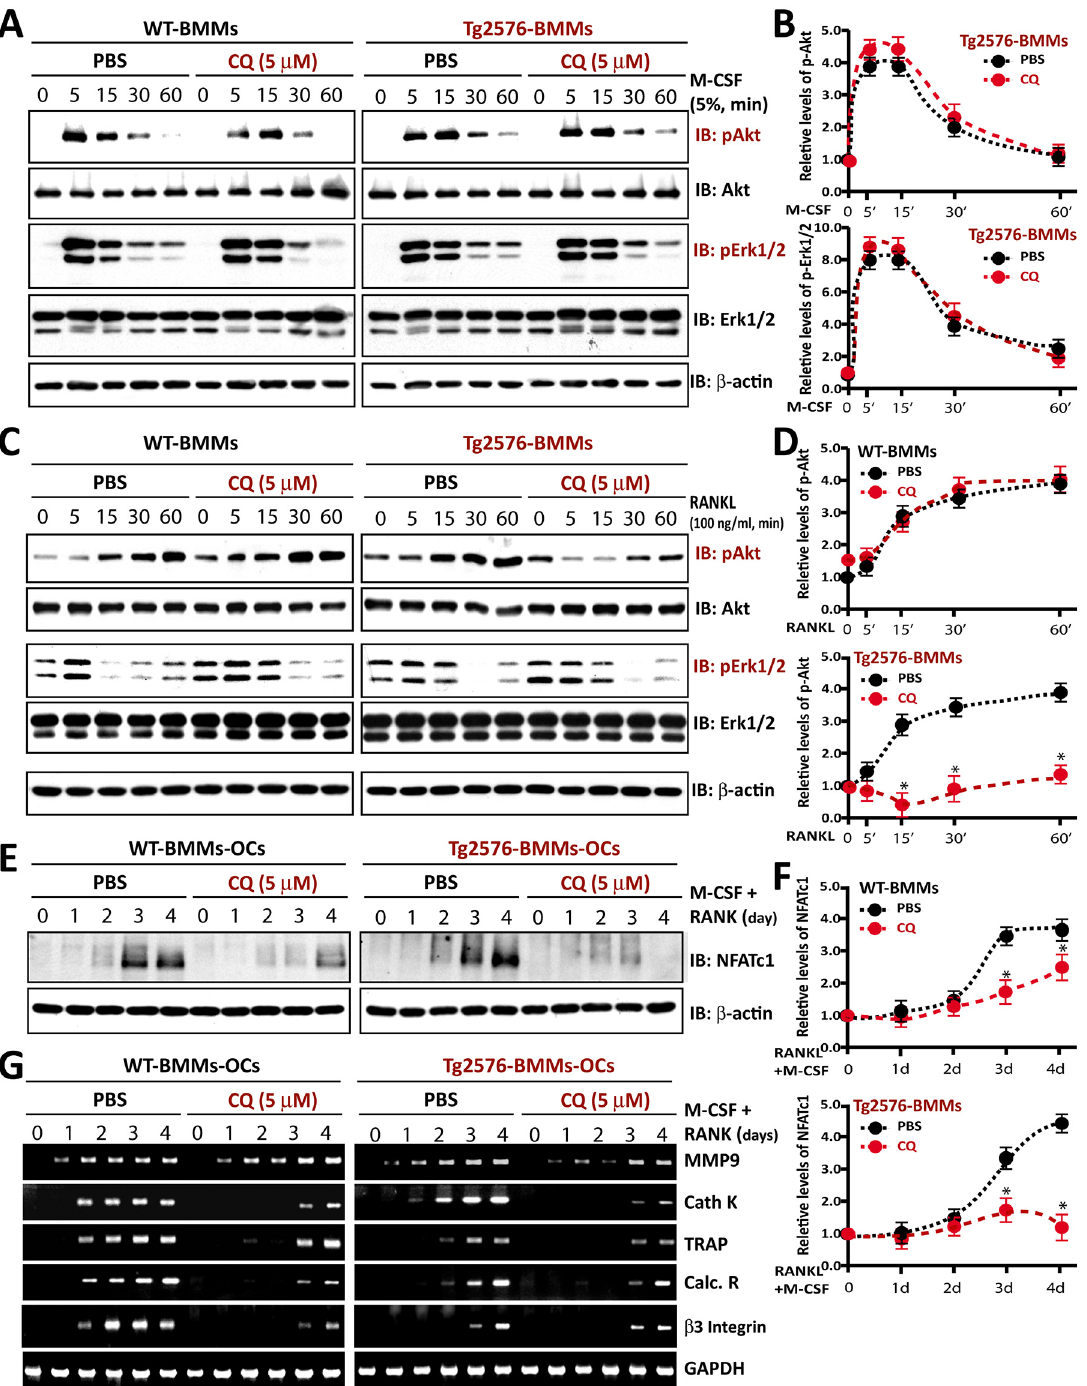
Fig 6. CQ effects on M-CSF- and RANKL-induced signaling in WT- and Tg2576-BMMs/pre-OCs in vitro. (A-B) CQ treatment had little to no effect on M-CSF-induced pErk1/2 and pAkt signaling in WT- and Tg2576-BMMs. A, Representative blots. B, Quantification analysis. The values of mean ± SD from 3 separate cultures were shown. (C-D) RANKL-induced Akt phosphorylation in Tg2576-BMMs, but not in WT-BMMs, was impaired by CQ treatment. C, Representative blots. D, Quantification analysis. The values of mean ± SD from 3 separate cultures were shown. * , P < 0.05, significant difference. (E-F) CQ reduced activation of the NFATc1 in both WT- and Tg2576-BMMs/pre-OCs. E, Representative blots. F, Quantification analysis. Note that a more dramatical reduction of NFATc1 activation by CQ was detected in Tg2576-BMMs-OC cultures. The values of mean ± SD from 3 separate cultures were shown. * , P < 0.05, significant difference. (G) RT-PCR analysis also showed reduced expression of genes associated with OC maturation, such as MMP9, calcitonin receptor (Calc. R), and beta3-integrin in CQ-treated cultures.